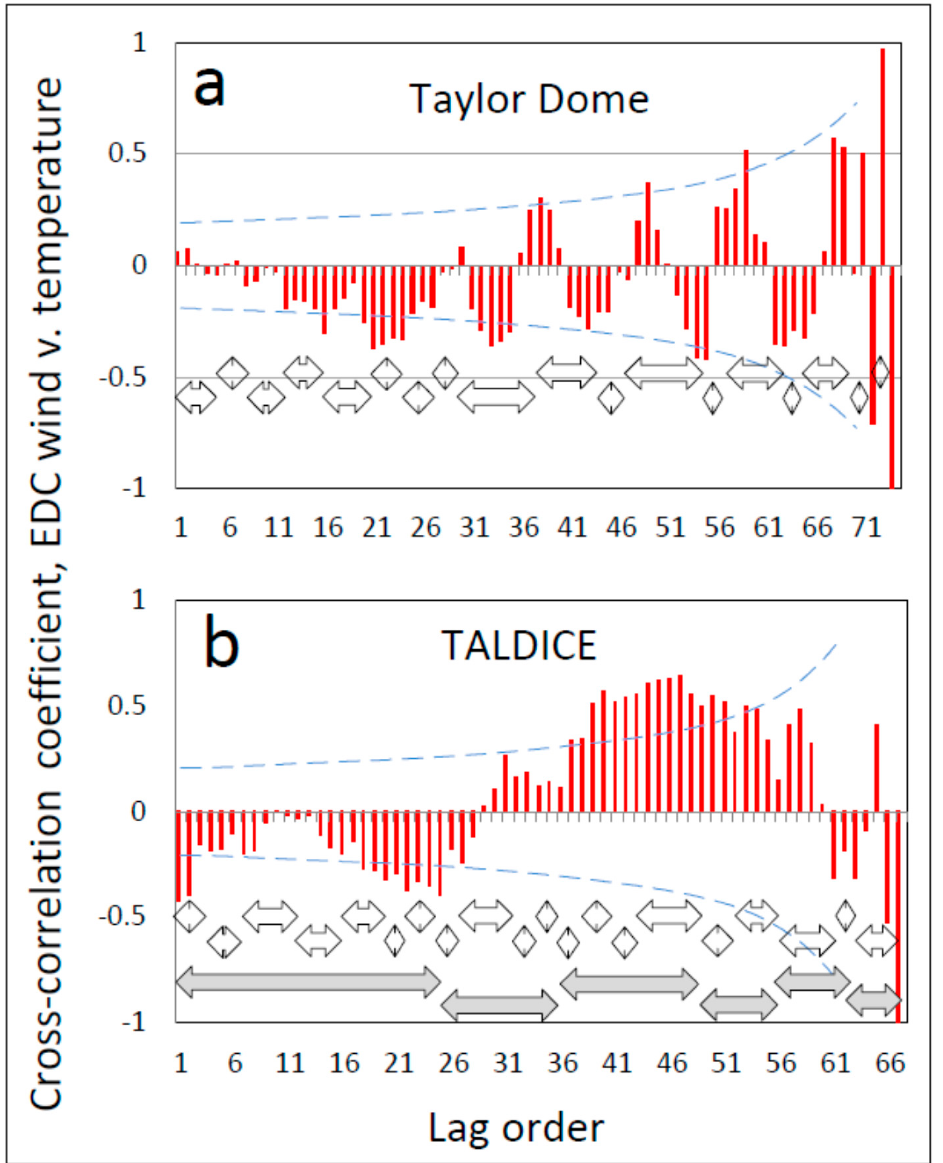
Figure 3. Progressive or lagged cross-correlation between wind proxies at EDC and temperature proxies at the indicated drill sites. ( a ) Cross-correlation between wind and temperature at Taylor Dome for the time period 70-61 thousand years before 2013 (Kyb2013). ( b ) Cross-correlation between wind and temperature at TALDICE for the time period from 4000-360 years before 1950 (Yb1950). The dashed blue lines in both graphs represent 95% confidence limits (positive and negative) for the value of the correlation coefficient associated with different lag orders (sample sizes). Double-headed open arrows demarcate the underlying centennial-scale periodicity visible in the cross-correlation record, while filled arrows show millennial-scale periodicity.